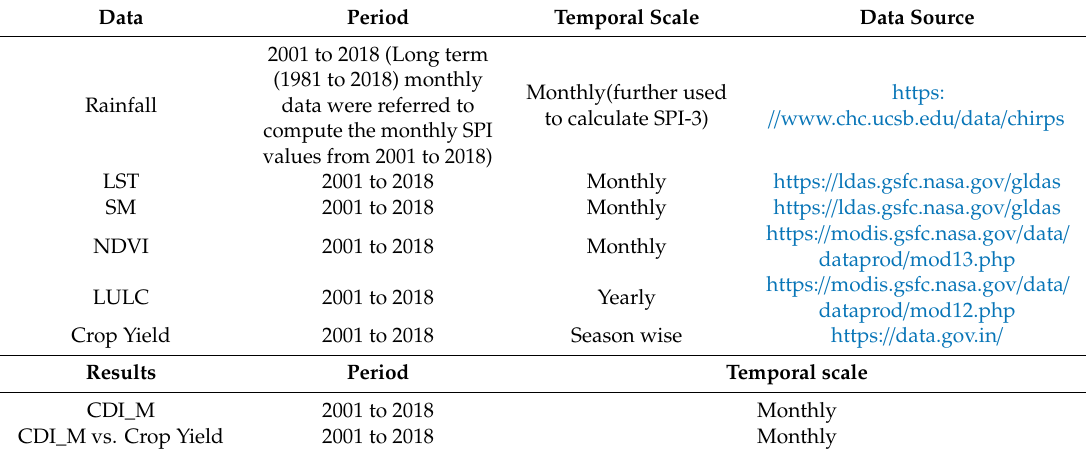
Table 1. Details of the temporal scales of the data used and the computed